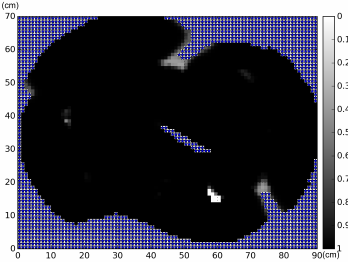
Figure 21. HMM parameter estimation of a 22 for observed space.